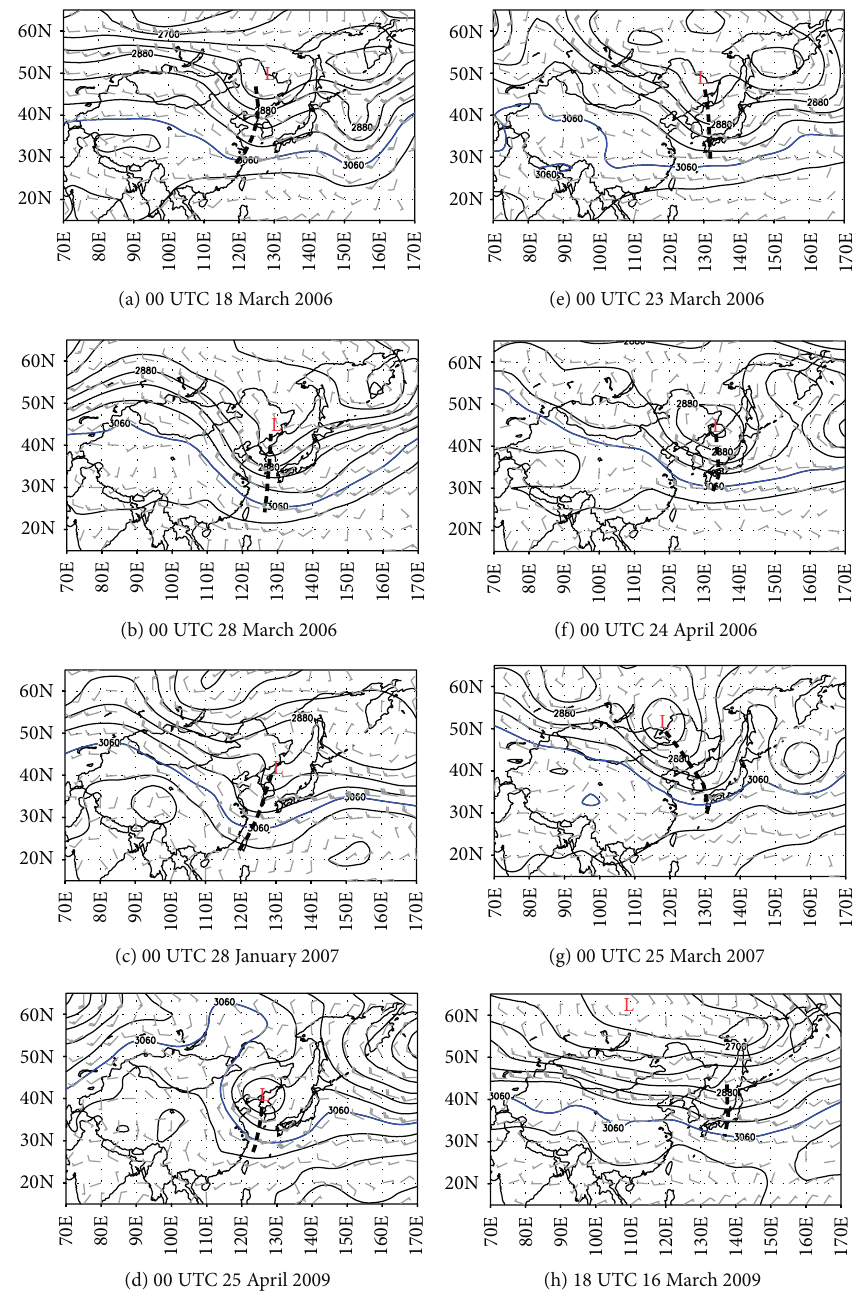
Figure 2: 700 hPa synoptic maps for the (a)–(d) southeastward and (e)–(h) eastward dust events. The full barb and half barb represent 10 and 5m s −1 , respectively. Geopotential heights (gpm, solid lines) are analyzed at 60 gpm intervals.